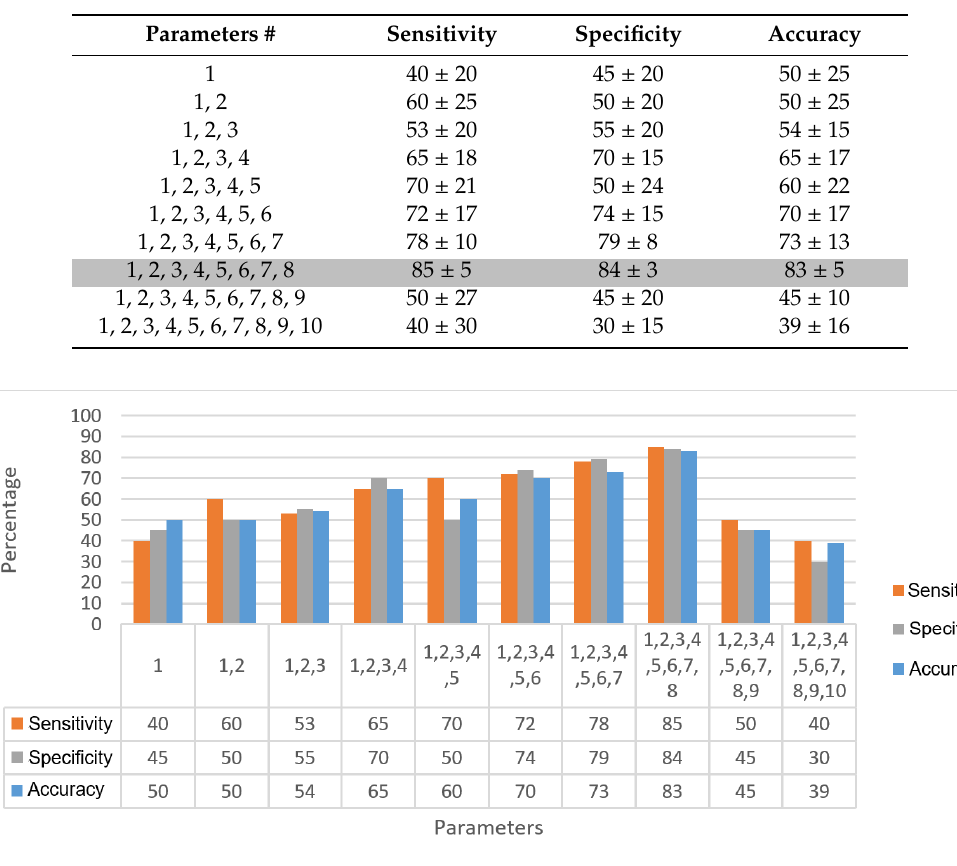
Table 4. Five-fold classification results using k-nearest neighbor (KNN).